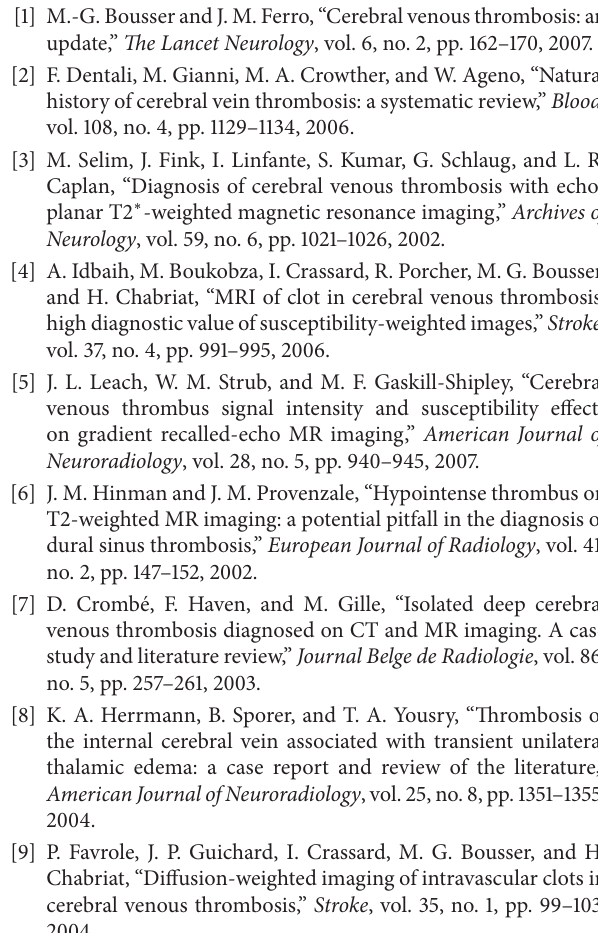
(isointense or hypointense on T1WI and hypointense on T2WI). Therefore, T2 ∗ WI could play an important role in the early detection of